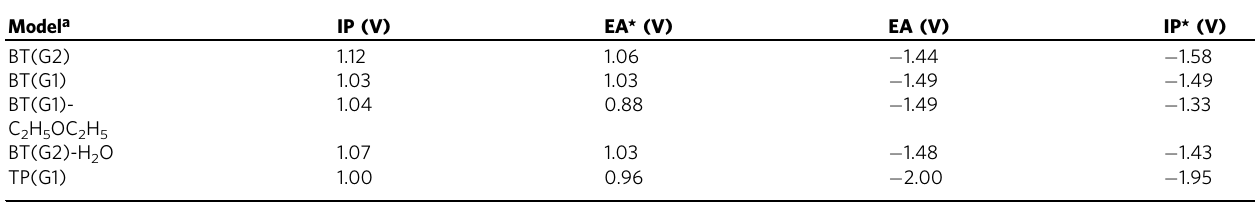
Table 1 Calculated redox potentials for the different BT-COF and TP-COF cut-out models and those combined with water and diethyl ether, as displayed in the inset,